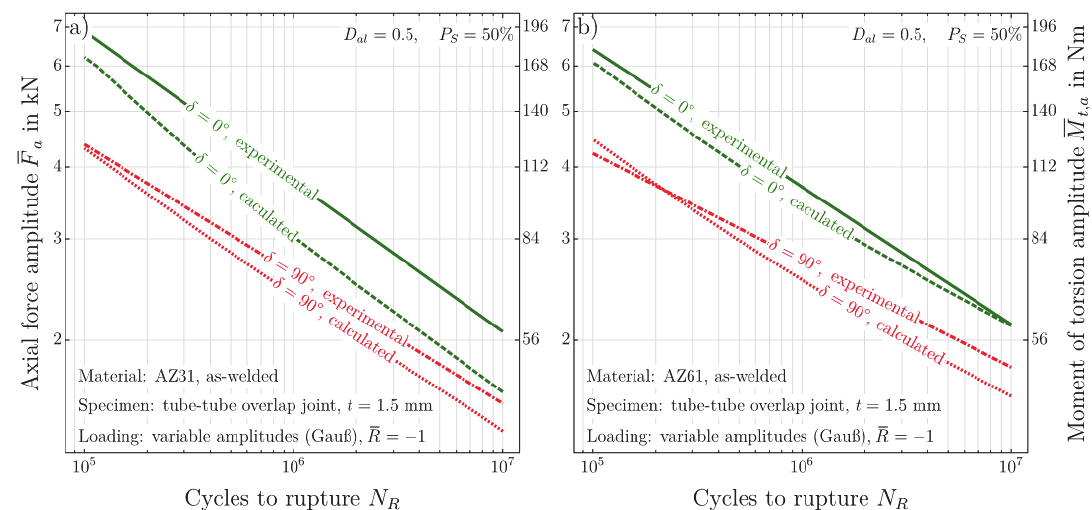
Figure 4: Computational and experimental Gaßner-lines for the welded joints made of AZ31 (a) and AZ61 (b) alloys,